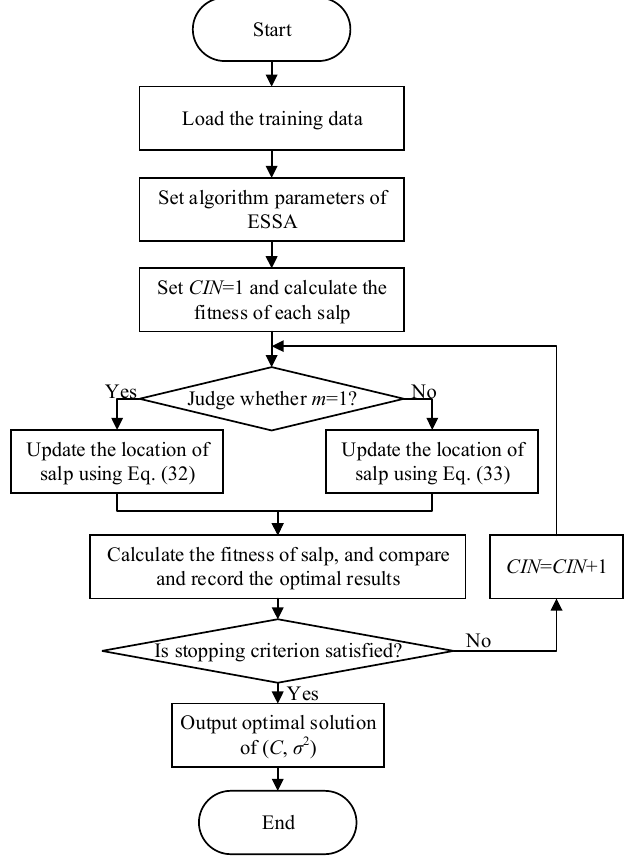
Figure 9. Flowchart of ESSA to optimize parameters C and σ 2 of